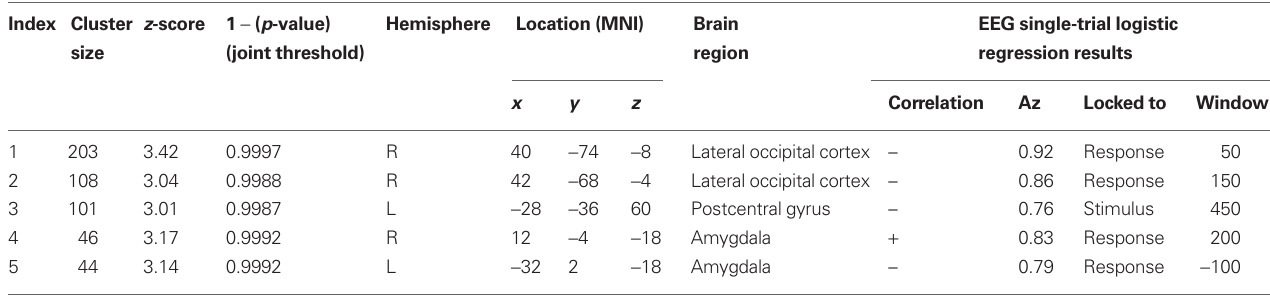
Table 1 | Significant clusters of activation in the original data of Goldman et al. (2009) .